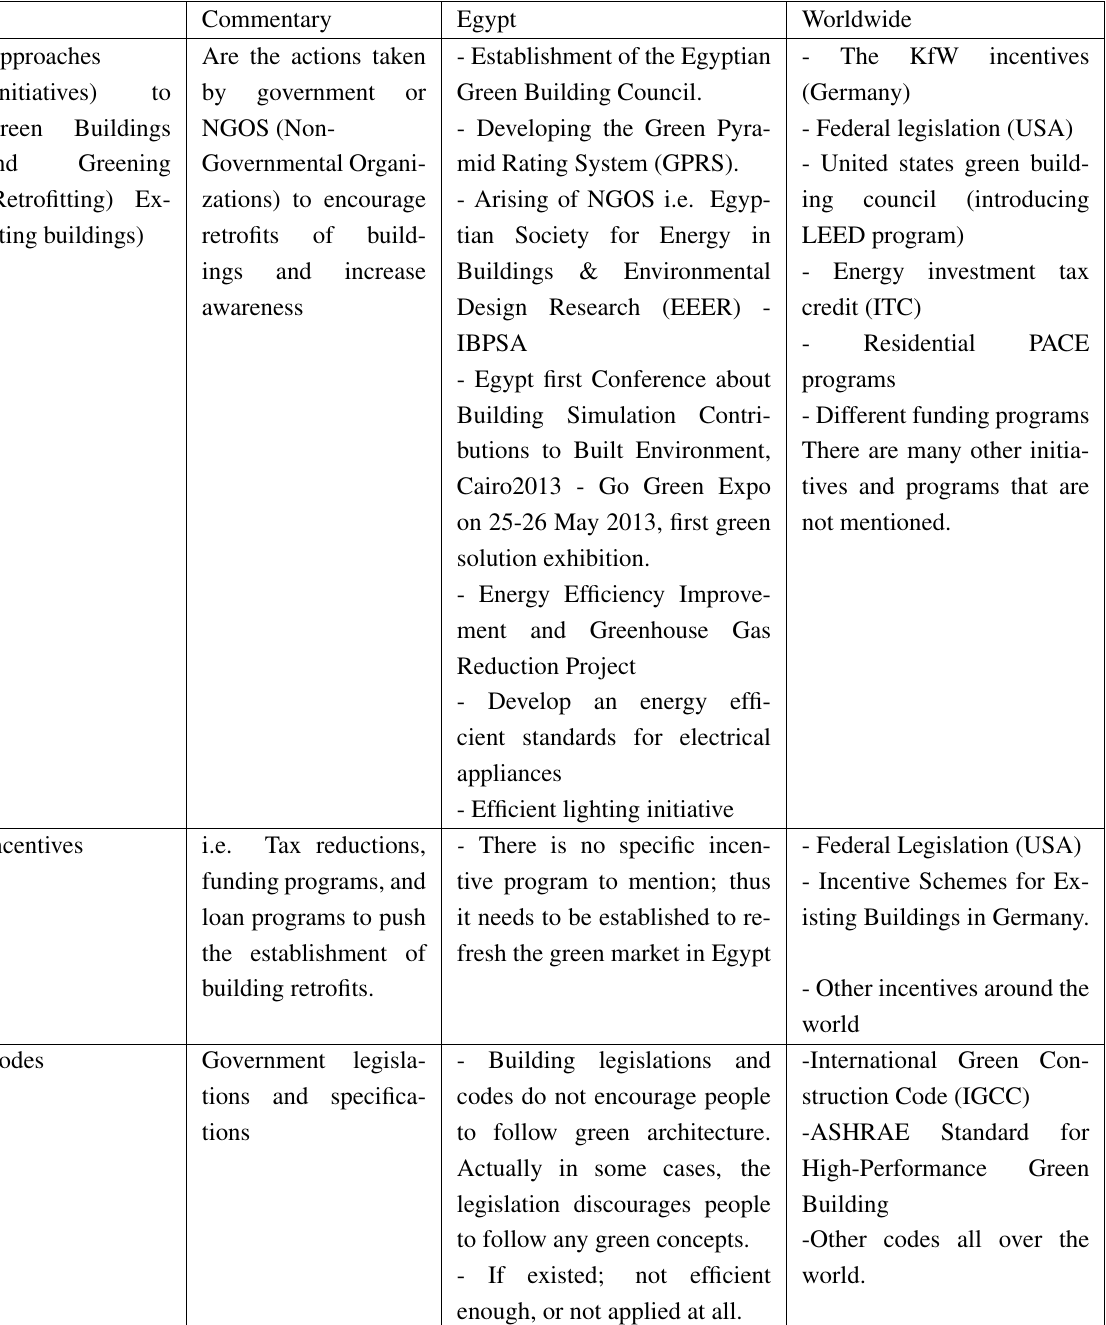
Table 4. Comparative Analysis of Egypt’s Green Market Business Case Current